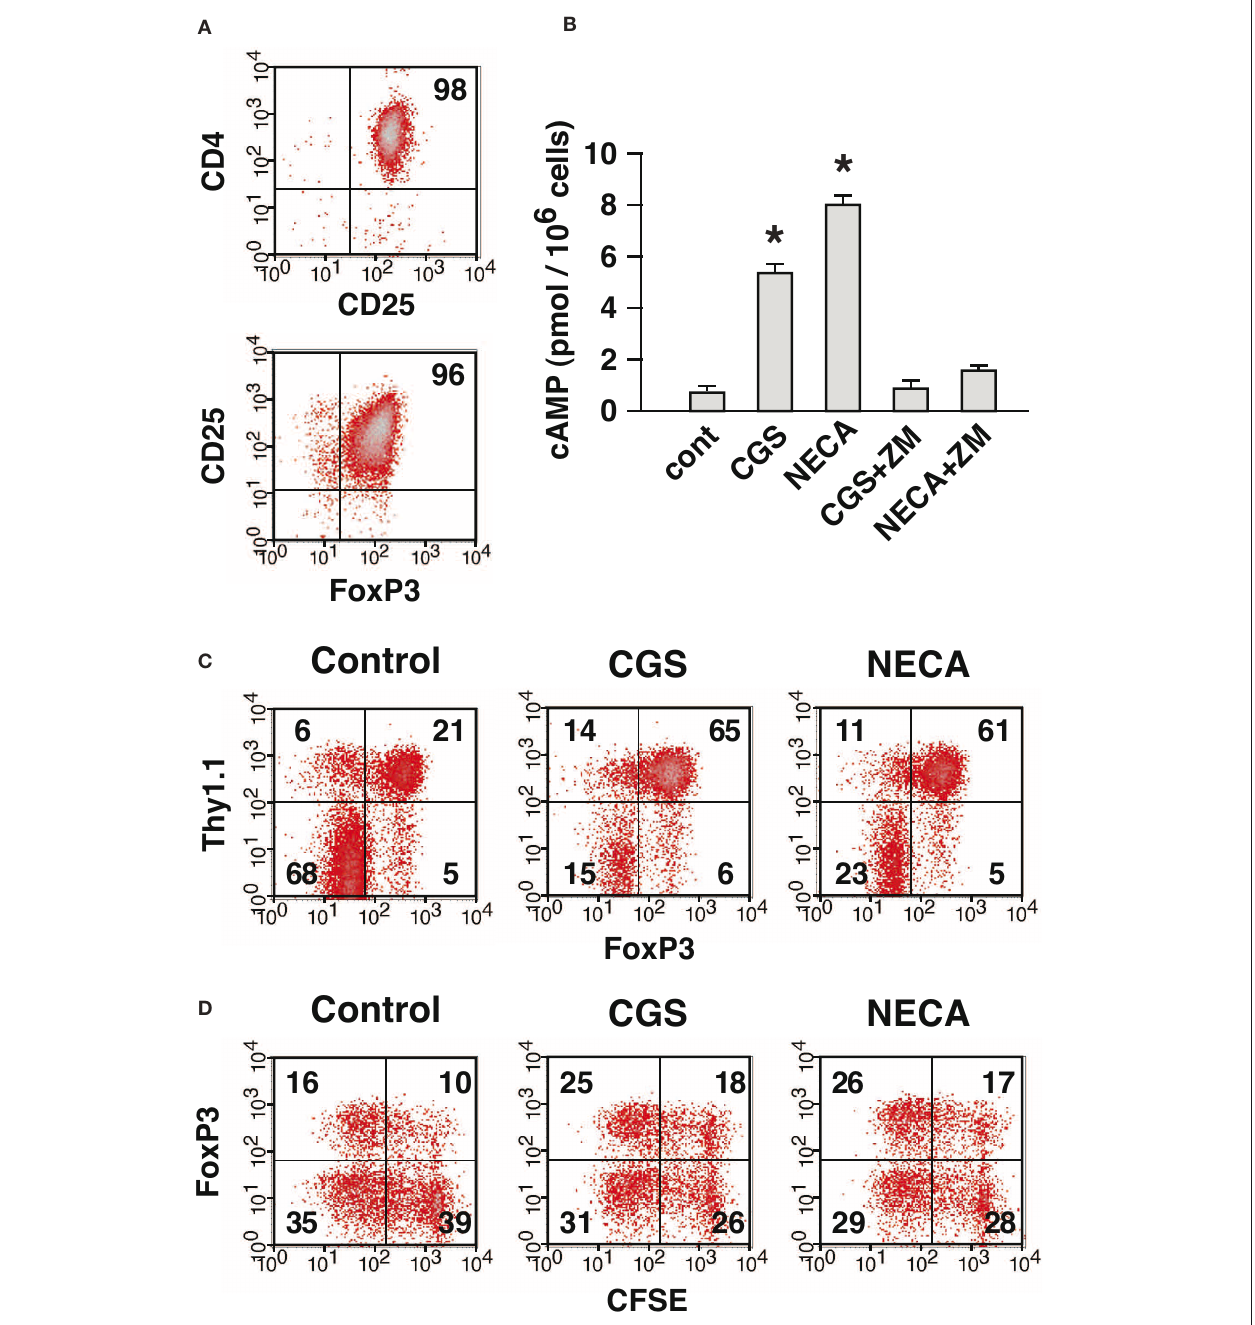
control. (C) A large part of A2AR-mediated increase of Treg was derived from nTreg. On day 7, the MLC was analyzed for the expression of FoxP3. The data were gated for CD4 + cells. The numbers represent percentages of each quadrant. Thy1.1 + (upper quadrants) and Thy1.1 − (lower quadrants) cells beginning of culture, respectively. (D) Active proliferation of nTreg in MLC and well-maintained FoxP3 expression by treatment with A2AR agonist. MLC responders were reconstituted as in (C) except that CD4 + CD25 + cells from Thy1.1-expressingmice were labeled with CFSE. The panels show CFSE fluorescence and FoxP3 expression in Thy1.1 + cells on day 4. The data shown here represent three separate experiments with similar